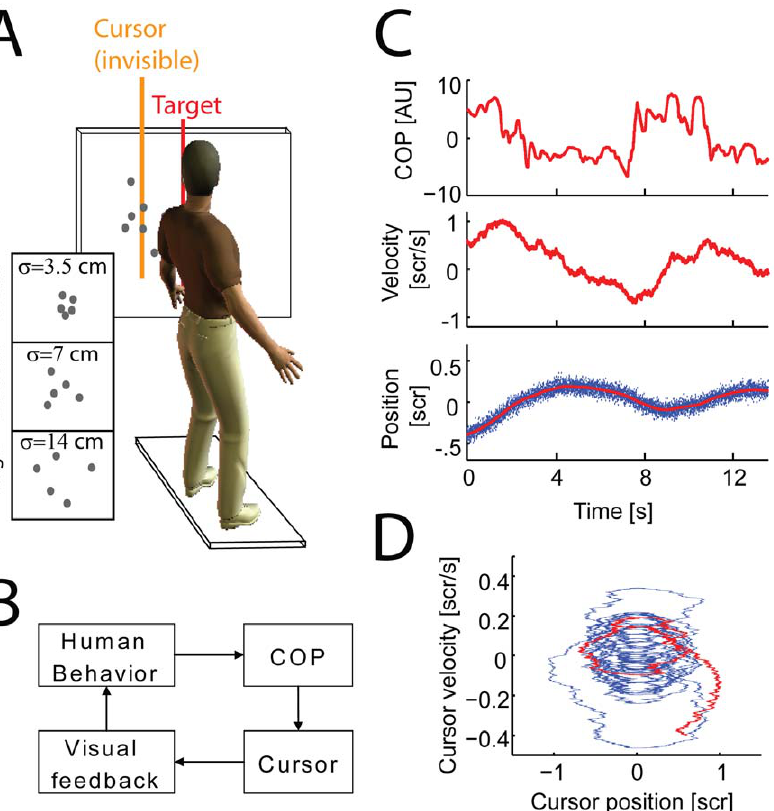
Figure 1. The task and data. A) The experimental setup. Subjects steer a cursor by shifts in center of pressure (COP) along the anterior-posterior axis. Noisy feedback of the cursor position (small, medium or large variance) is given while subjects are incentivized to steer the cursor to be close to the midline of the screen (target). B) Subject’s movements affect the center of pressure, which is measured by a force plate. The resulting sensor readings then steer the on-screen cursor. Subjects receive noisy visual feedback about the cursor position and react to reduce errors. C) COP, cursor velocity and cursor position are shown as a function of time during one trial for a typical subject (red). The observed feedback (noisy dots) is shown in blue. D) The phase portrait of cursor position and velocity is shown for 10 successive trials. Data from (C) are highlighted in red.